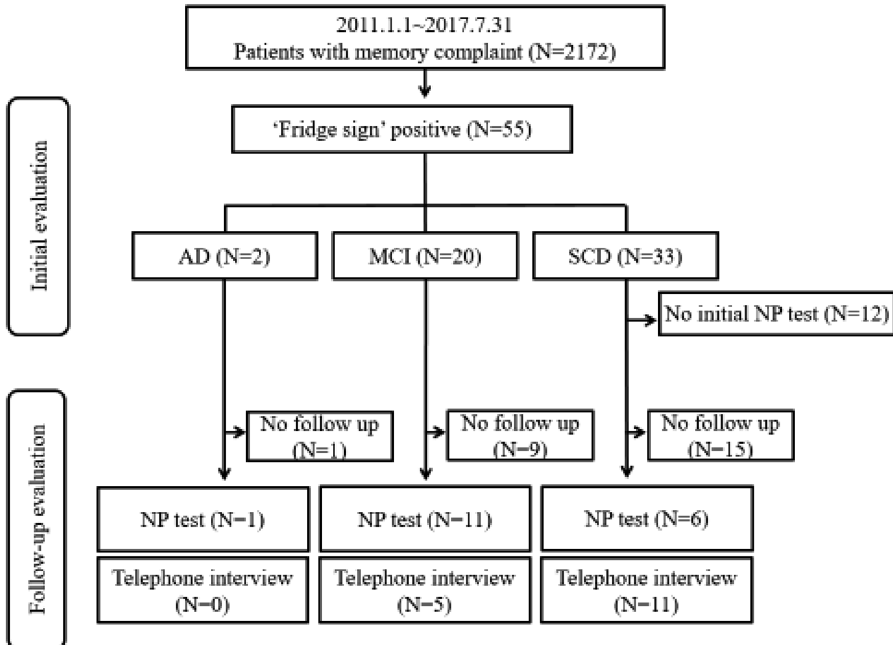
Figure 1. Flow chart of included patients. SCD subjective cognitive decline, MCI mild cognitive impairment, AD Alzheimer’s dementia, NP test neuropsychological test. The figure was generated using Microsoft PowerPoint 2013 (https ://www.micro